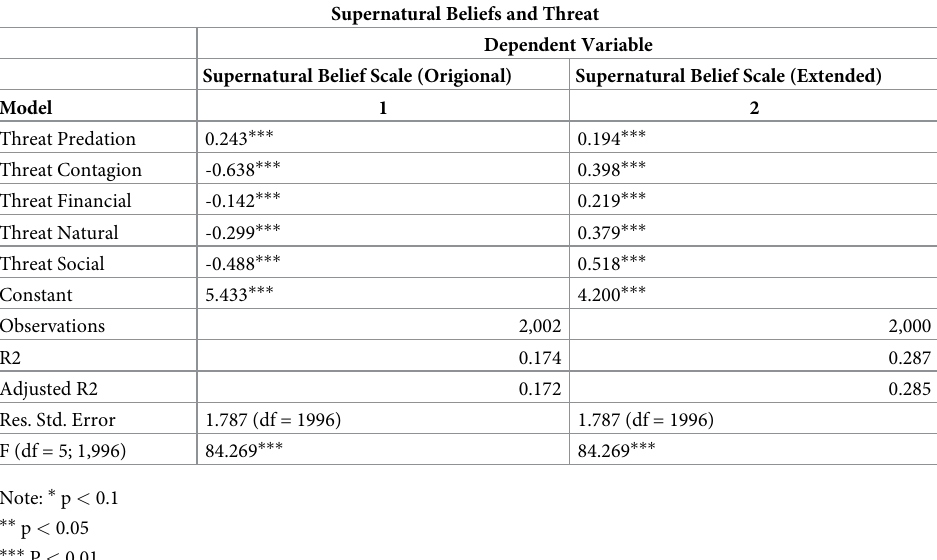
Table 4. Effect of threats on supernatural beliefs.